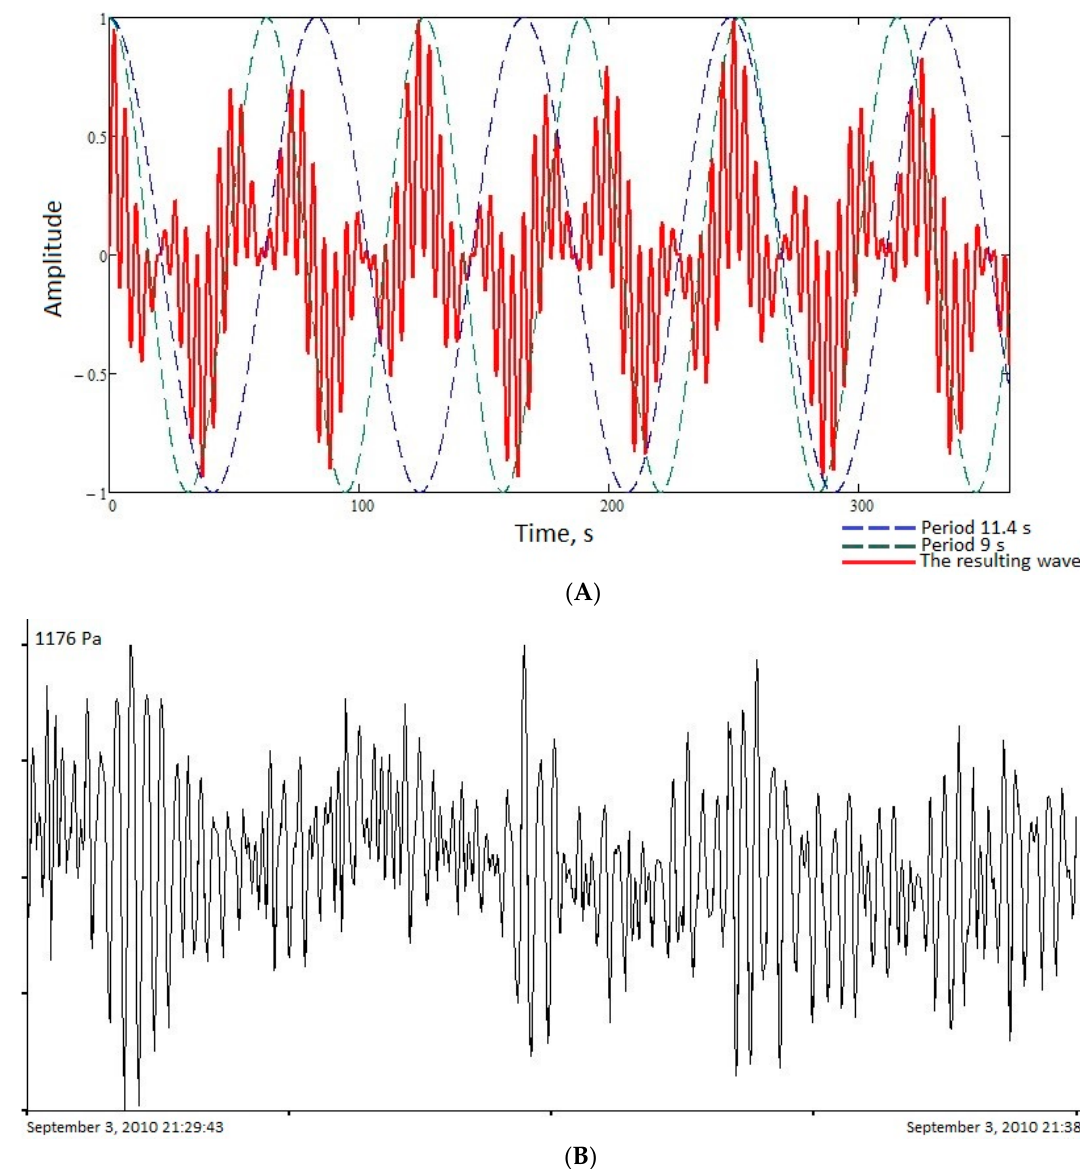
Figure 11. ( A ) Group of waves formed with a period of 11.4 s, which captured a wave with a period of 9 s, which, in turn, captured a wave with a period of 7 s (11.4 s enveloping curve—blue dotted line, 9 s enveloping curve—green dotted line, and red line is the resulting wave, consisting of three wave periods). ( B ) Record fragment of the laser meter of hydrosphere pressure variations of the typhoon arrival area, shown for comparison.